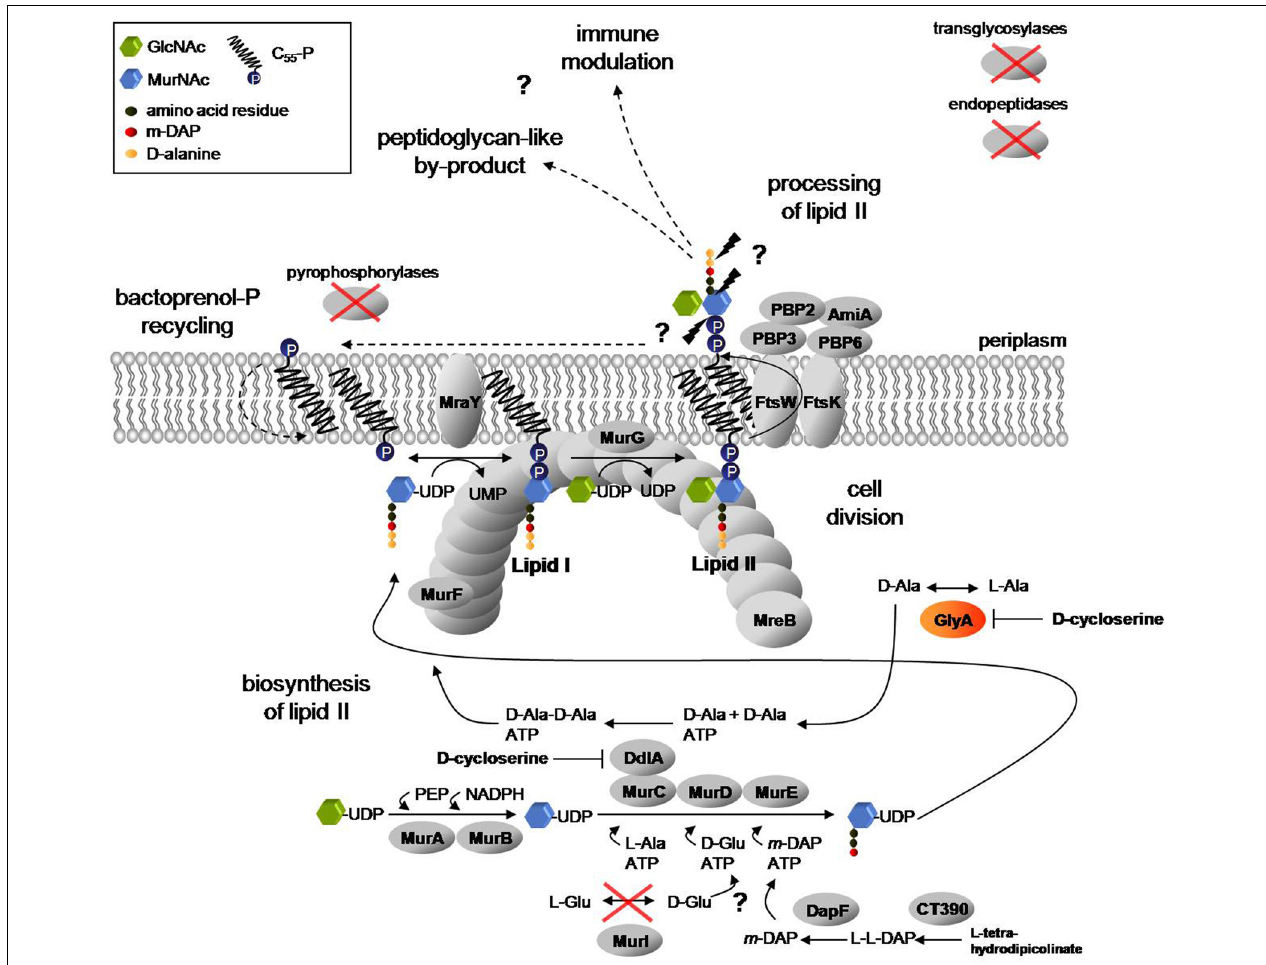
FIGURE 1 | Proposed lipid II pathway in Chlamydiaceae . A complete cycle of lipid II biosynthesis, including translocation to the periplasm, processing and bactoprenolcarrierrecyclingisrequiredforcoordinatedfunctionofthedivisome machineryandmodulationofNod1andNod2mediatedhostimmuneresponse tochlamydialmuropeptides.BiosynthesisoflipidIItakesplaceinthecytoplasm and at the inner leaflet of the cytoplasmic membrane. In two